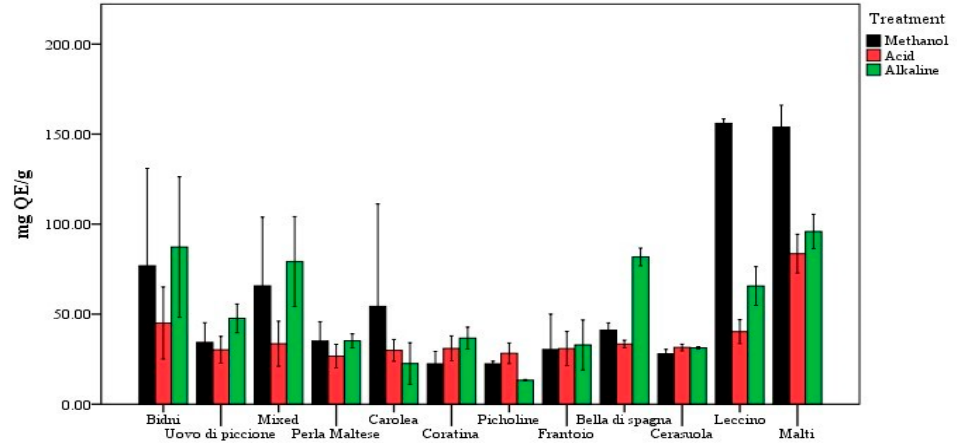
Figure 3. Mean values for total flavonoid content (TFC) of olive mill waste extracts using three dif- ferent solvent extraction methods—methanol, acid and alkaline (black, red and green bars, respec- tively) with error bars showing ± 1SD for three independent trails.